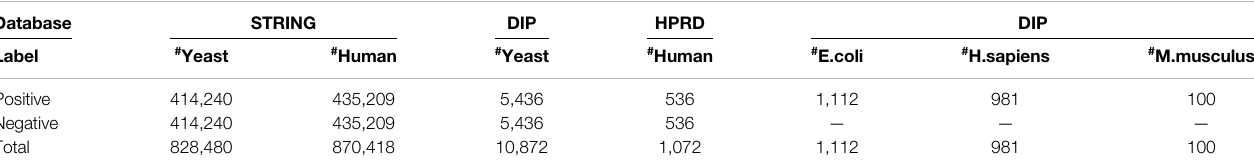
TABLE 1 | The number of PPIs in seven test datasets after the preprocessing.